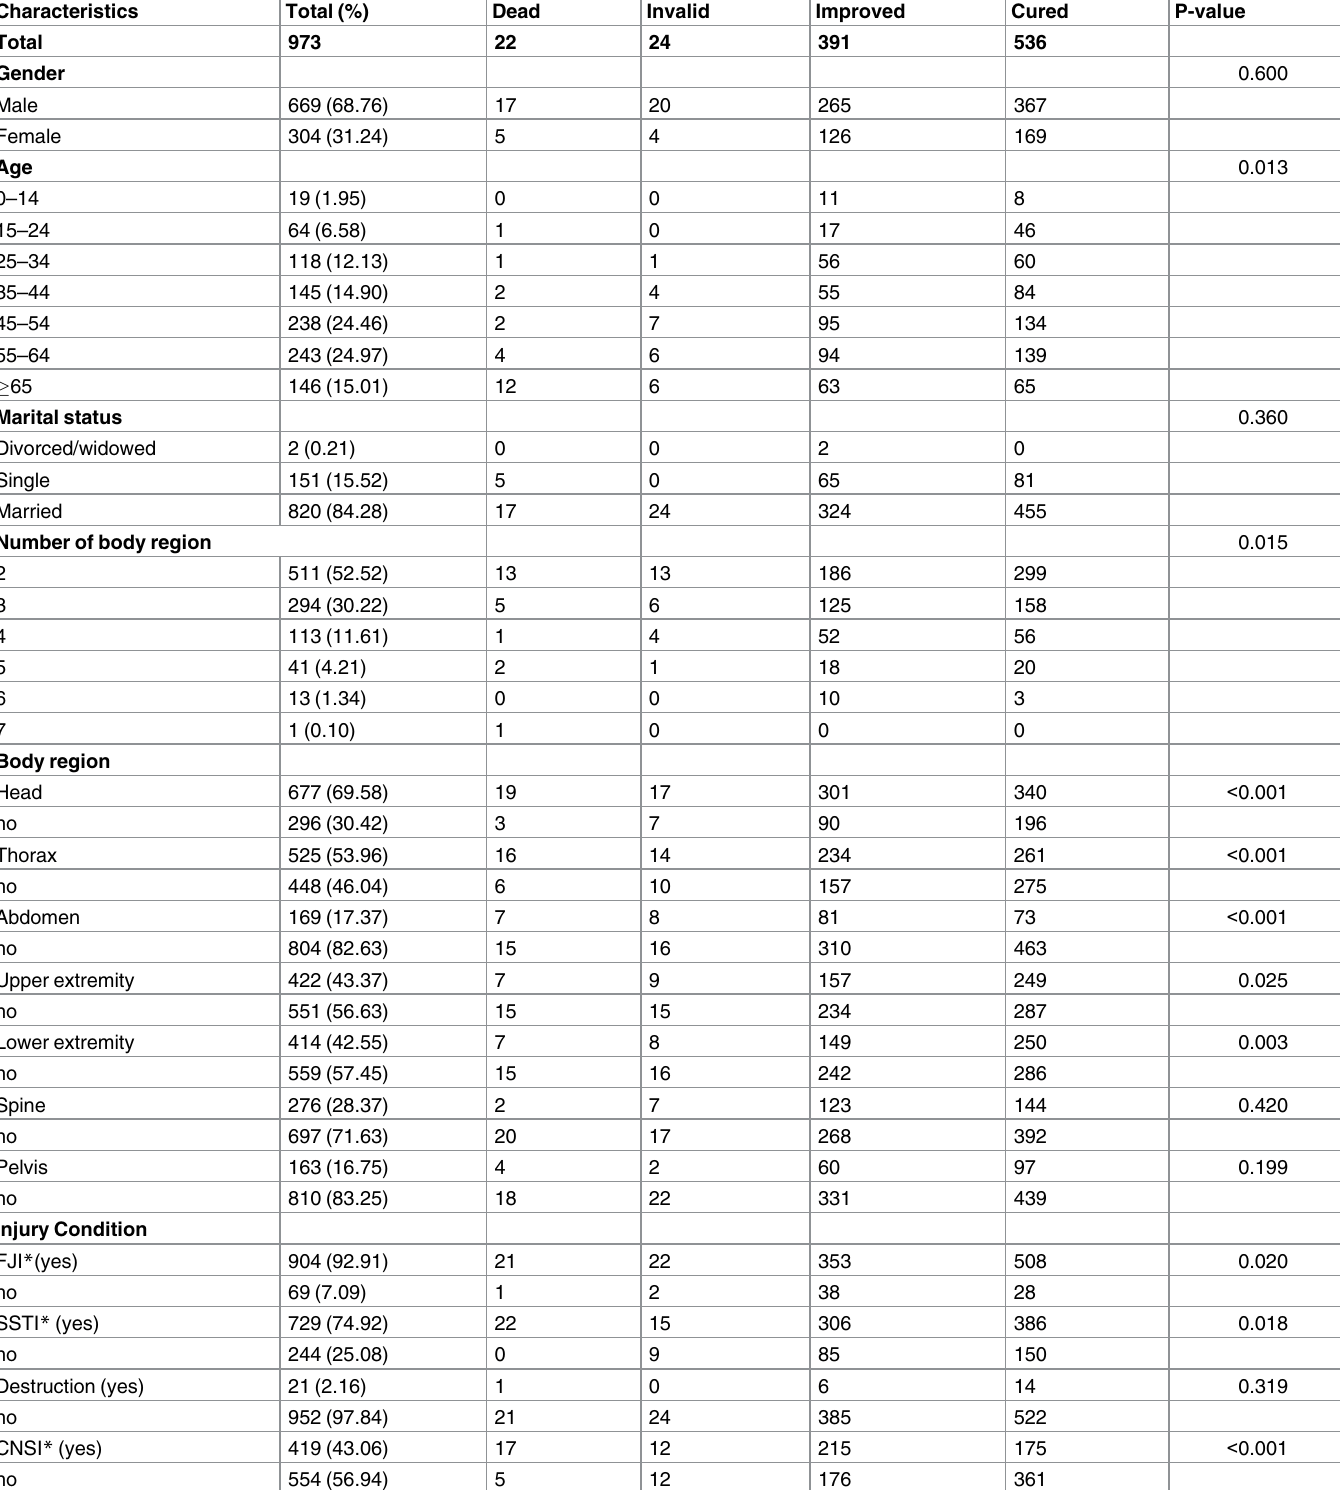
Table 2. Descriptiveanalysis and univariate analysis for multiple-RTI